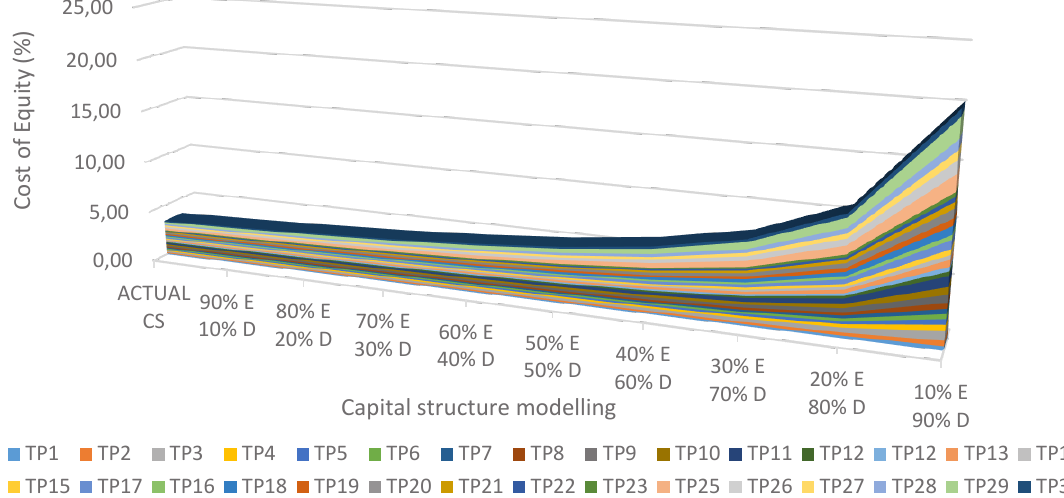
Figure 1. Development of the cost of equity following the change in capital